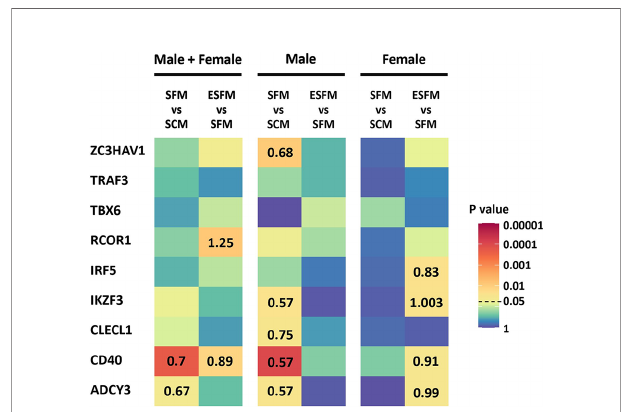
FIGURE 6 | Effect of serum depletion and estradiol treatment of LCLs on the expression of nine MS risk genes. Left, LCLs are grouped to include both male and female LCLs combined (n = 42); center, male LCLs (n = 21); right, female LCLs (n = 21). Heatmap shows the statistical signi fi cance (p value) of the fold change in expression between serum-free medium and serum-containing medium (SFM vs SCM), or estradiol treated versus serum-free medium (ESFM vs SFM). For the comparisons that were statistically signi fi cant (p value less than 0.05), the fold changes are represented with numbers in the corresponding cells. Fold change values greater and less than one denotes increased and decreased expression levels, respectively. MS risk gene expression was measured by RT-qPCR. PCR was performed in duplicate with expression relative to RPL30. Expression relative to RPL30. Colors represent the p value as calculated by expression relative to RPL30. Wilcoxon matched-pairs signed rank test performed (two-tailed). Wilcoxon matched-pairs signed rank test performed (two-tailed). SCM, serum-containing medium; SFM, serum-free medium; ESFM, serum-free medium with additional estradiol at a fi nal concentration of 100 nM (see Materials and Methods